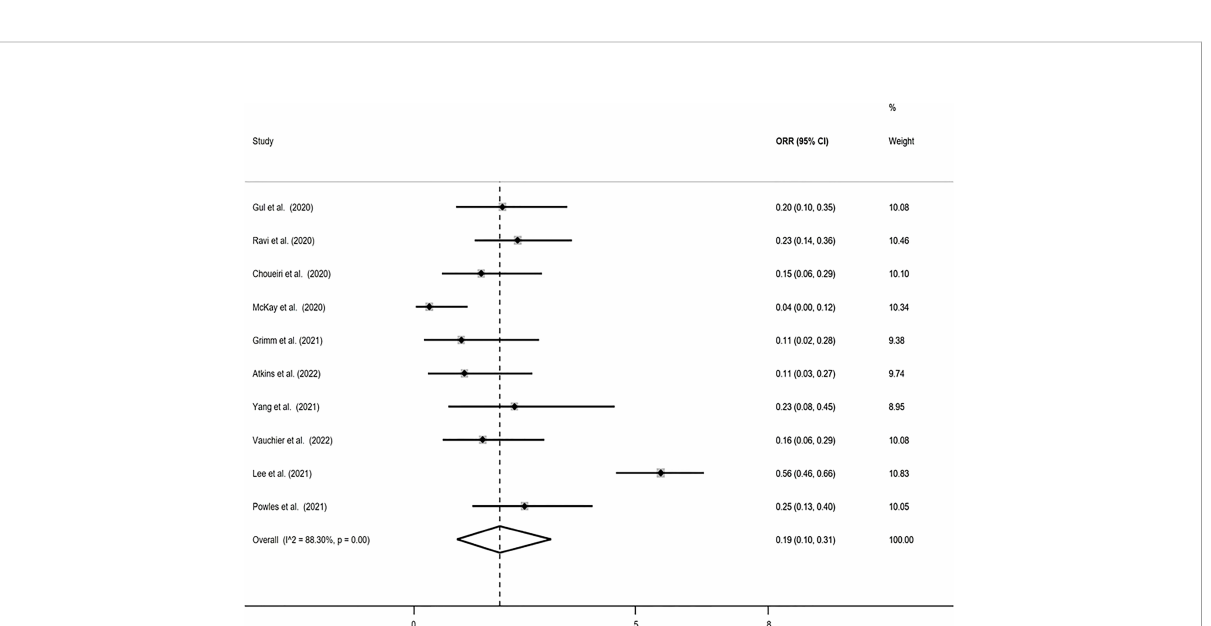
FIGURE 2 Forest plot displaying the pooled objective response rate (ORR) proportion in random-effects meta-analysis with the Freeman-Tukey double arcsine transformation.